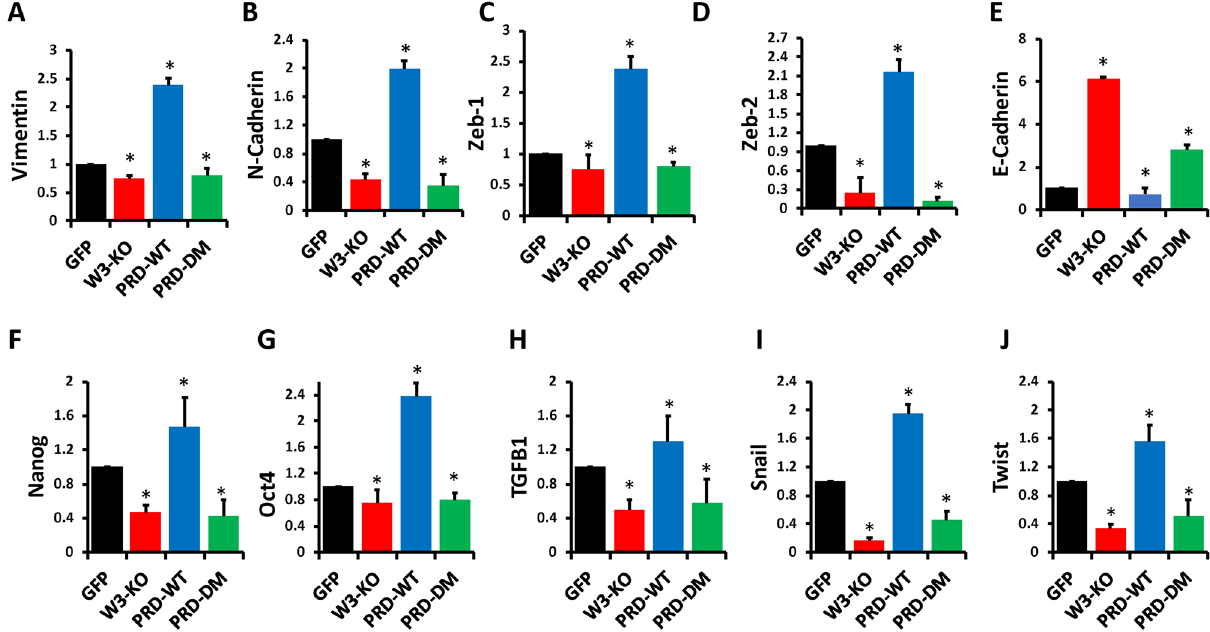
Figure 6. Phosphorylation of the WAVE3 PRD domain is required for the WAVE3-mediated regulation of the EMT-program and for the YB1-mediated regulation of the cancer stem cell niche: qt-RT-PCR data. Quantitative RT-PCR of mRNA of ( A ) Vimentin ( B ) N-Cadherin ( C ) Zeb-1 ( D ) Zeb-2 ( E ) E-Cadherin ( F ) Nanog ( G ) Oct4 ( H ) TGFβ1 ( I ) Snail and ( J ) Twist from parental (GFP) MDA-MB-231, WAVE3-deficient (W3-KO) MDA-MB-231 cells, or W3-KO MDA-MB-231 cells that were transfected with either wild-type WAVE3-PRD- GFP fusion (PRD-WT) or phospho-mutant WAVE3-PRD-GFP fusion (PRD-DM). GAPDH was used for normalization. Data are the means ± SD, N = 3, * represents p < 0.05 compared to GFP, Student’s